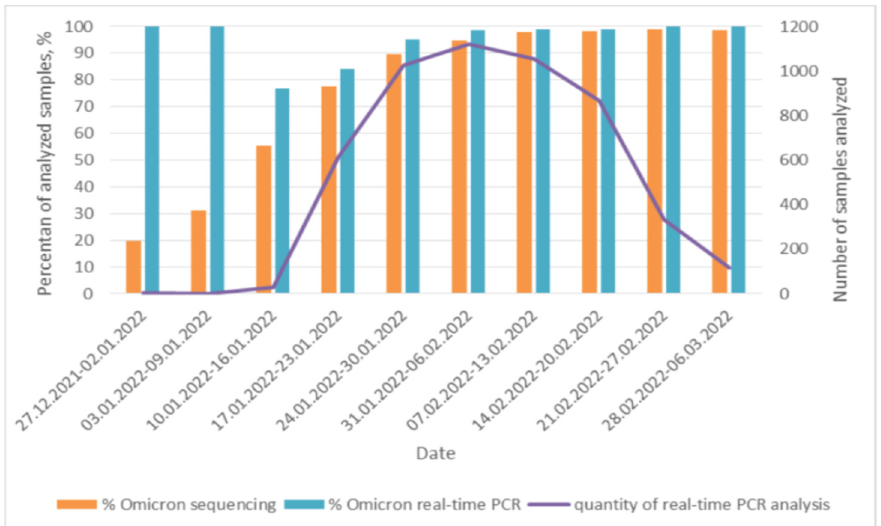
Figure 3. Comparative characteristics of the proportion of detectability of the Omicron genovariant by real-time PCR and sequencing methods.